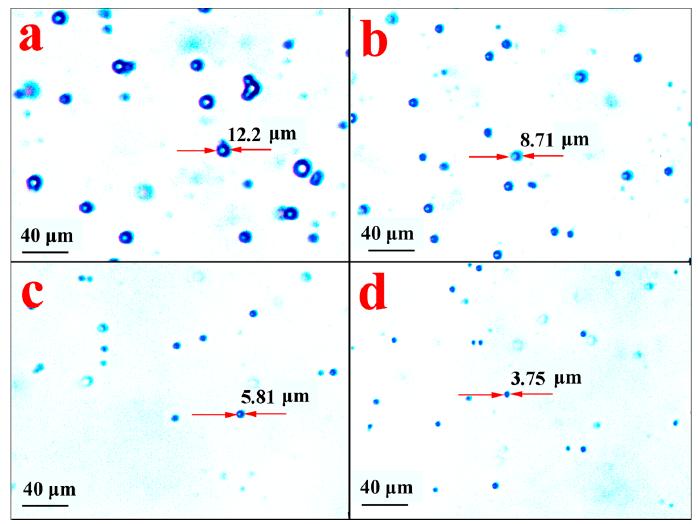
Figure 12. Morphology of ABMP microspheres under an optical microscope after release for ( a ) 0 h; ( b ) 10 h; ( c ) 20 h; and ( d ) 40 h in PBS. The diameter of a typical particle is labeled in each picture.